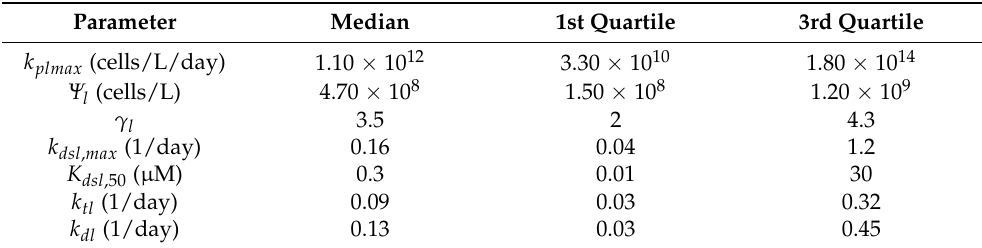
Figure 16. Observation versus individual prediction for absolute neutrophil count (ANC) of all data points across the population, with each color marking an individual participant. The solid line represents y = x; the dashed lines represent 10% error. Table 4. Leukopoiesis model parameter estimates for HUSTLE